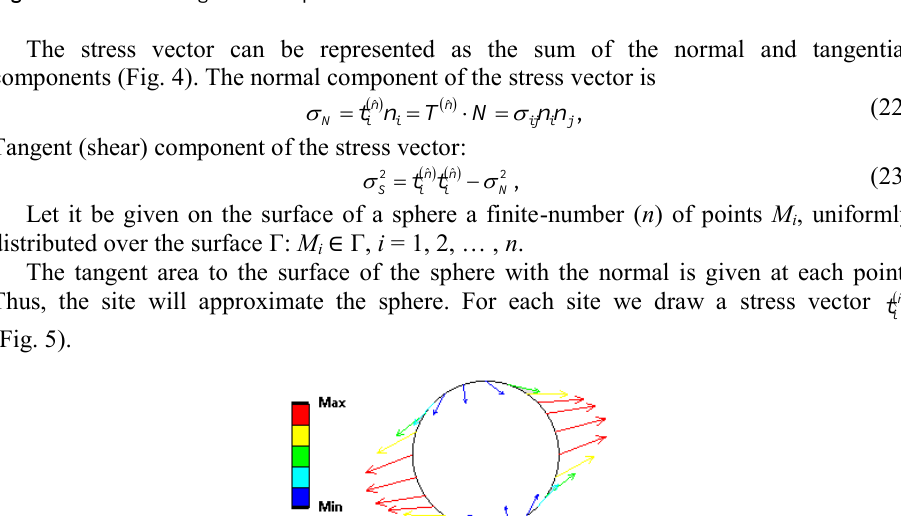
Fig. 4. Normal and tangential components of stress vector.